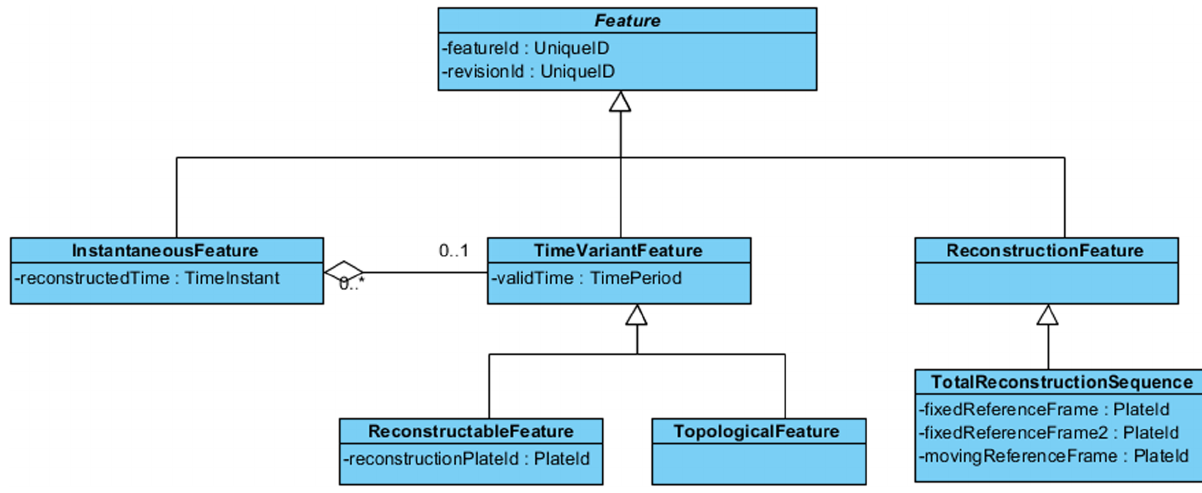
Fig. 1. UML diagram of GPGIM